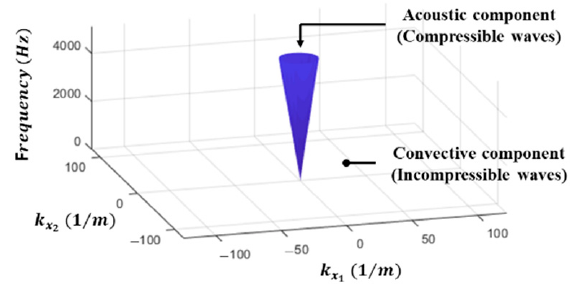
Figure 1. Illustrative slanted Dirac cone separating incompressible and compressible parts in three- dimensional periodogram: U 0 = 110 km/h and c 0 = 343 m/s.